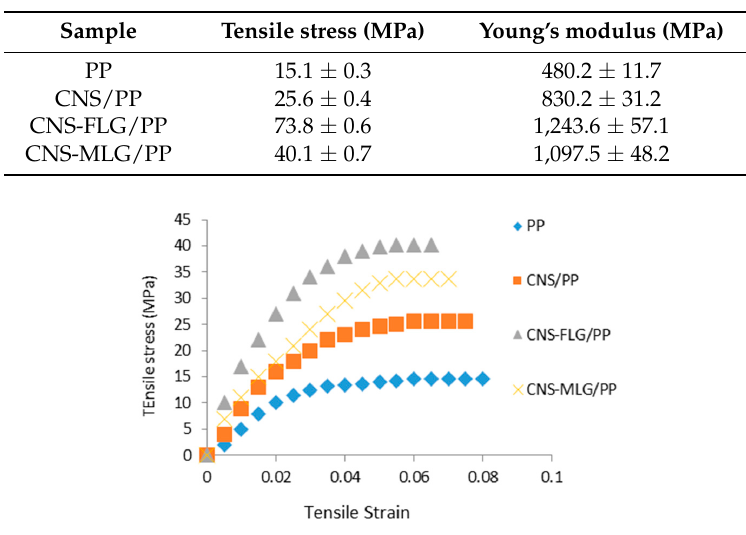
Table 1. Mechanical results of the different nanocomposites (5% nanofiller, 95% PP).